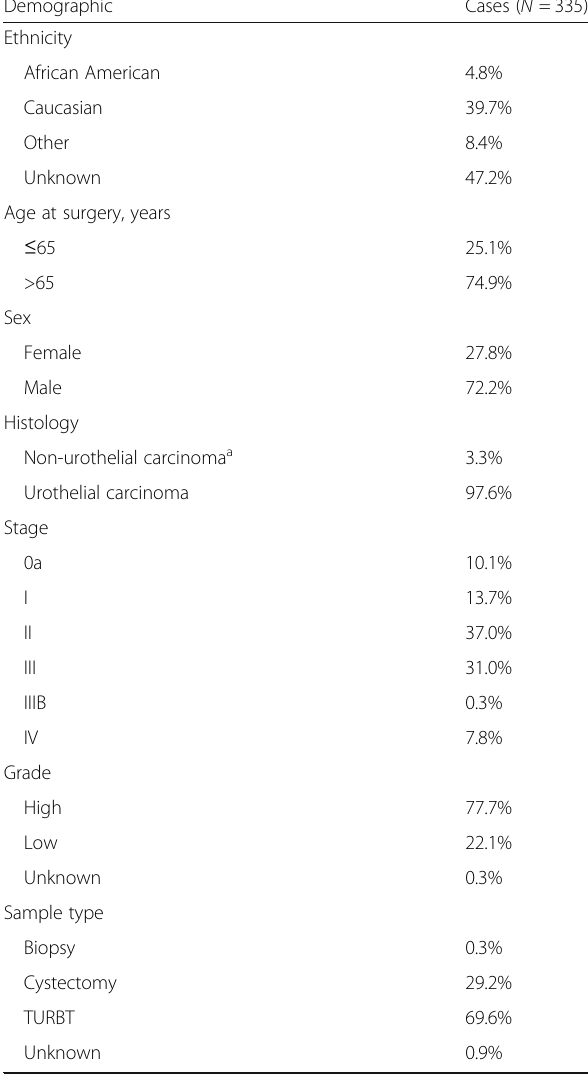
Table 1 Patient demographics and baseline characteristics